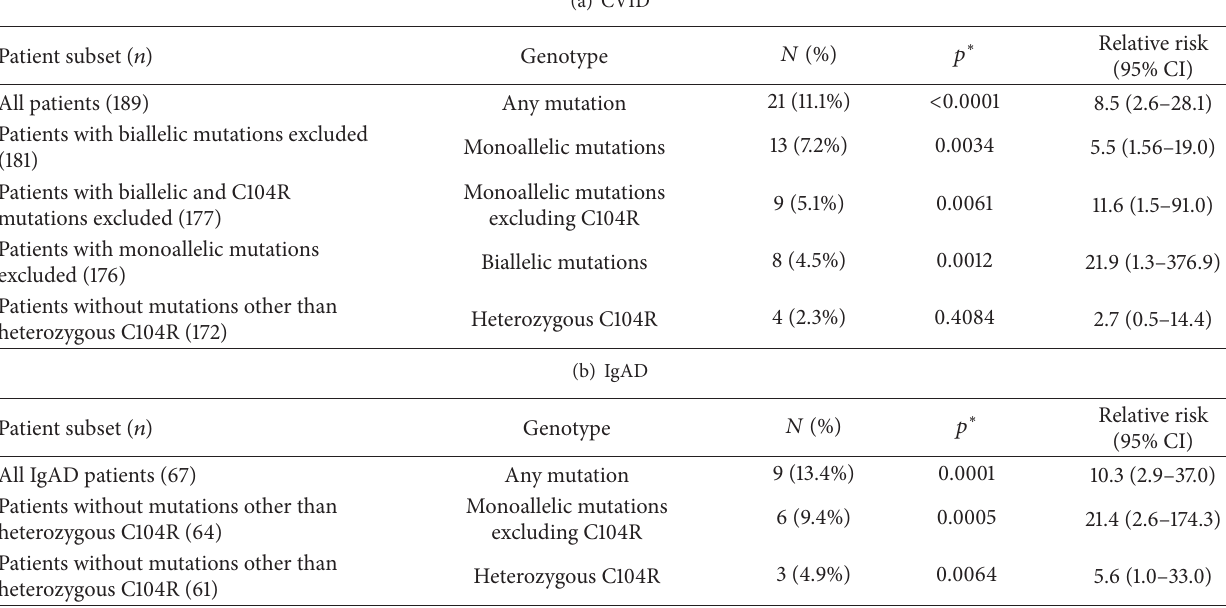
Table 1: Frequencies, significance, and relative risk of TNFRSF13B mutations in 189 CVID (a) and in 67 IgAD (b) Italian patients compared with healthy controls.